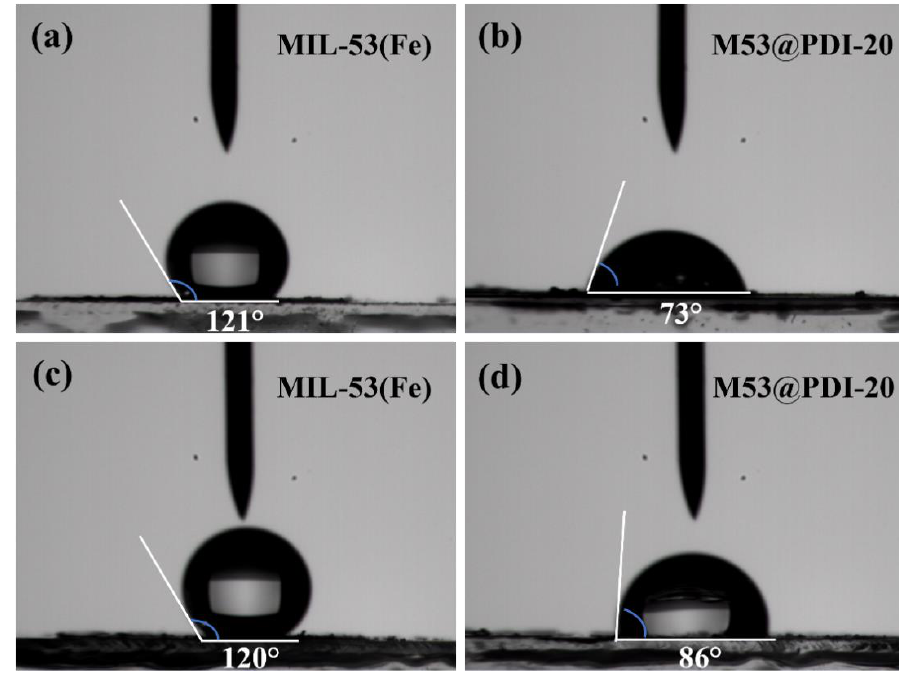
Figure 8. Images of contact angles of MIL-53(Fe) ( a ) and M53@PDI-20 ( b ) with 10 mg/L RhB solution; images of contact angles of MIL-53(Fe) ( c ) and M53@PDI-20 ( d ) with 10 mg/L Cr(IV) solution.